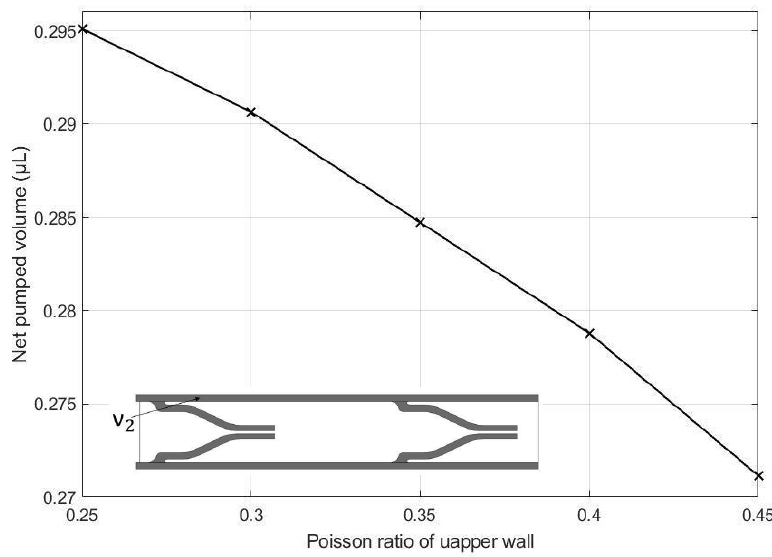
Figure 21. Effect of Poisson’s ratio of the upper wall on the net pumped volume .